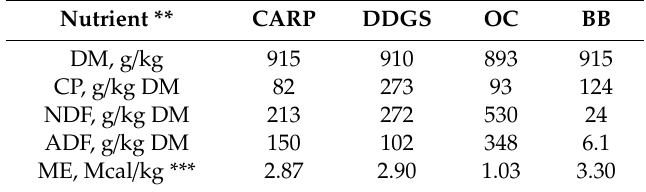
Table 1. Chemical composition of alternative feeds (AF) * used in the